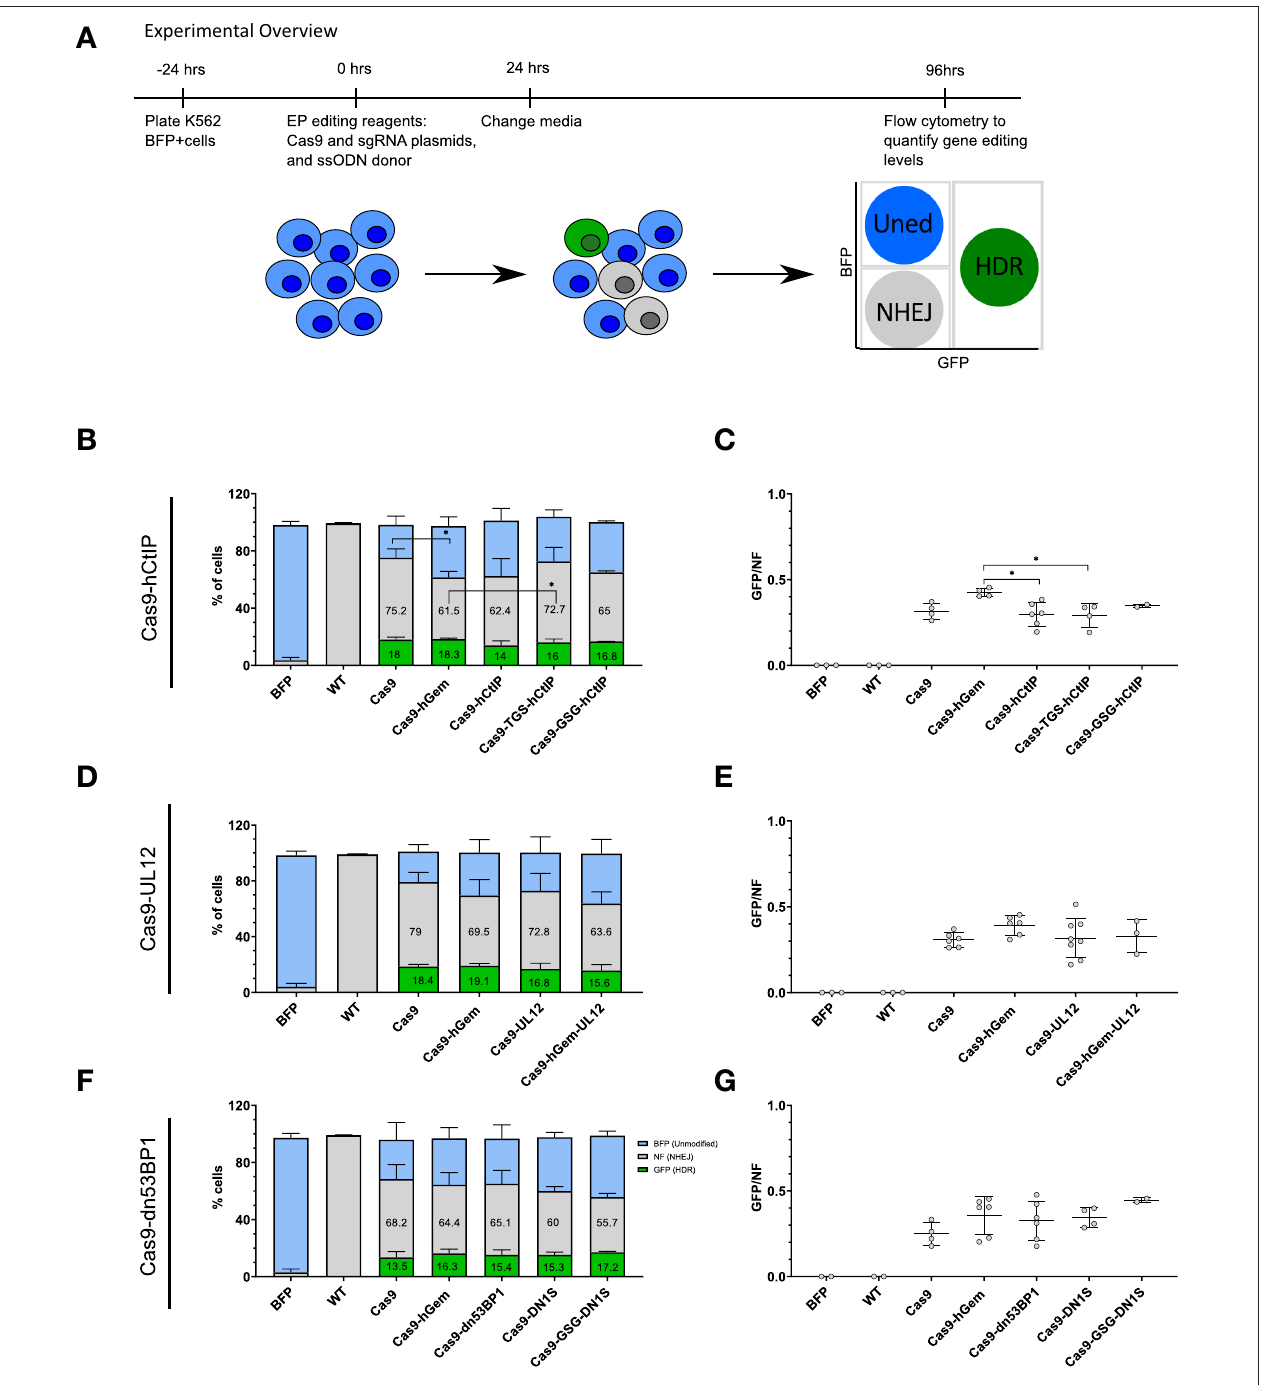
FIGURE 4 | Preliminary assessment of Cas9 variants to modulate local gene editing outcomes in a K562 BFP reporter cell line. (A) Experimental overview of electroporation of Cas9 variants as plasmid into a K562 BFP reporter cell line. K562 BFP cells were electroporated with 1 µ g Cas9 variant plasmid, 1 µ g of sgRNA plasmid targeting the BFP gene, and a ssODN donor (3 µ M). Cells were cultured for 4 days post-electroporation prior to analysis by flow cytometry. (B–G) Proportion of GFP + , BFP + , or NF cells and GFP/NF ratio of cells edited with Cas9-hCtIP variants, n = 2–6 biological replicates (B,C) , and Cas9-UL12 variants, n = 3–8 biological replicates (D,E) , and Cas9-dn53BP1, n = 2–6 biological replicates (F,G) . Error bars, mean ± SD. Differences are not significant if not specified, * p < 0.05, based on Wilcoxon rank sum test.